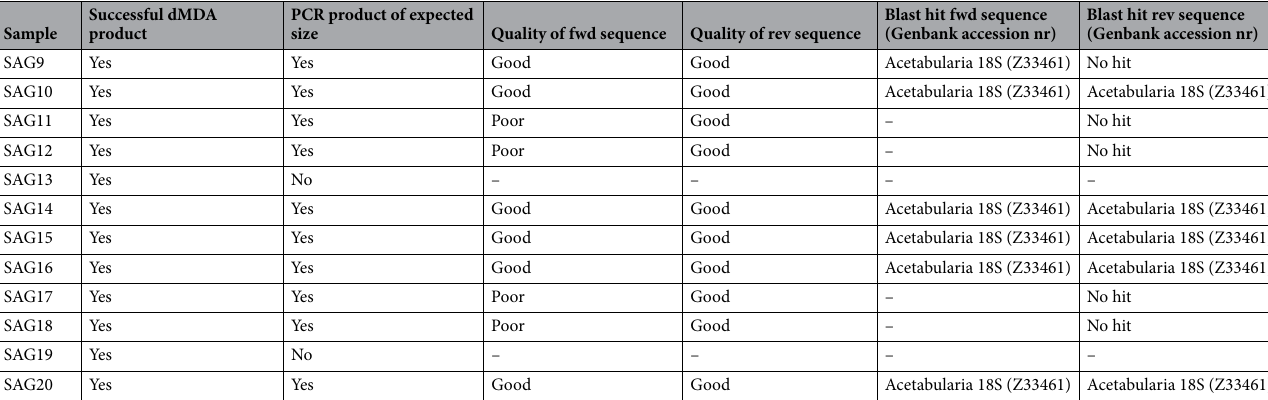
Table 1. Amplification of genomic DNA from A. acetabulum embryonic cells using dMDA. Successful dMDA product was determined if high-molecular weight DNA was clearly visible on an agarose gel. “ fwd” and “rev” sequence refers to PCR products sequenced with the 1F and EUK1134R primers respectively (see "Methods"). These sequences were considered to be of “good” quality if the sequencing chromatogram showed a clear and for the most part unambiguous sequence, and “poor” if otherwise. “Poor” sequences were not Blasted as no reliable sequence could be generated.